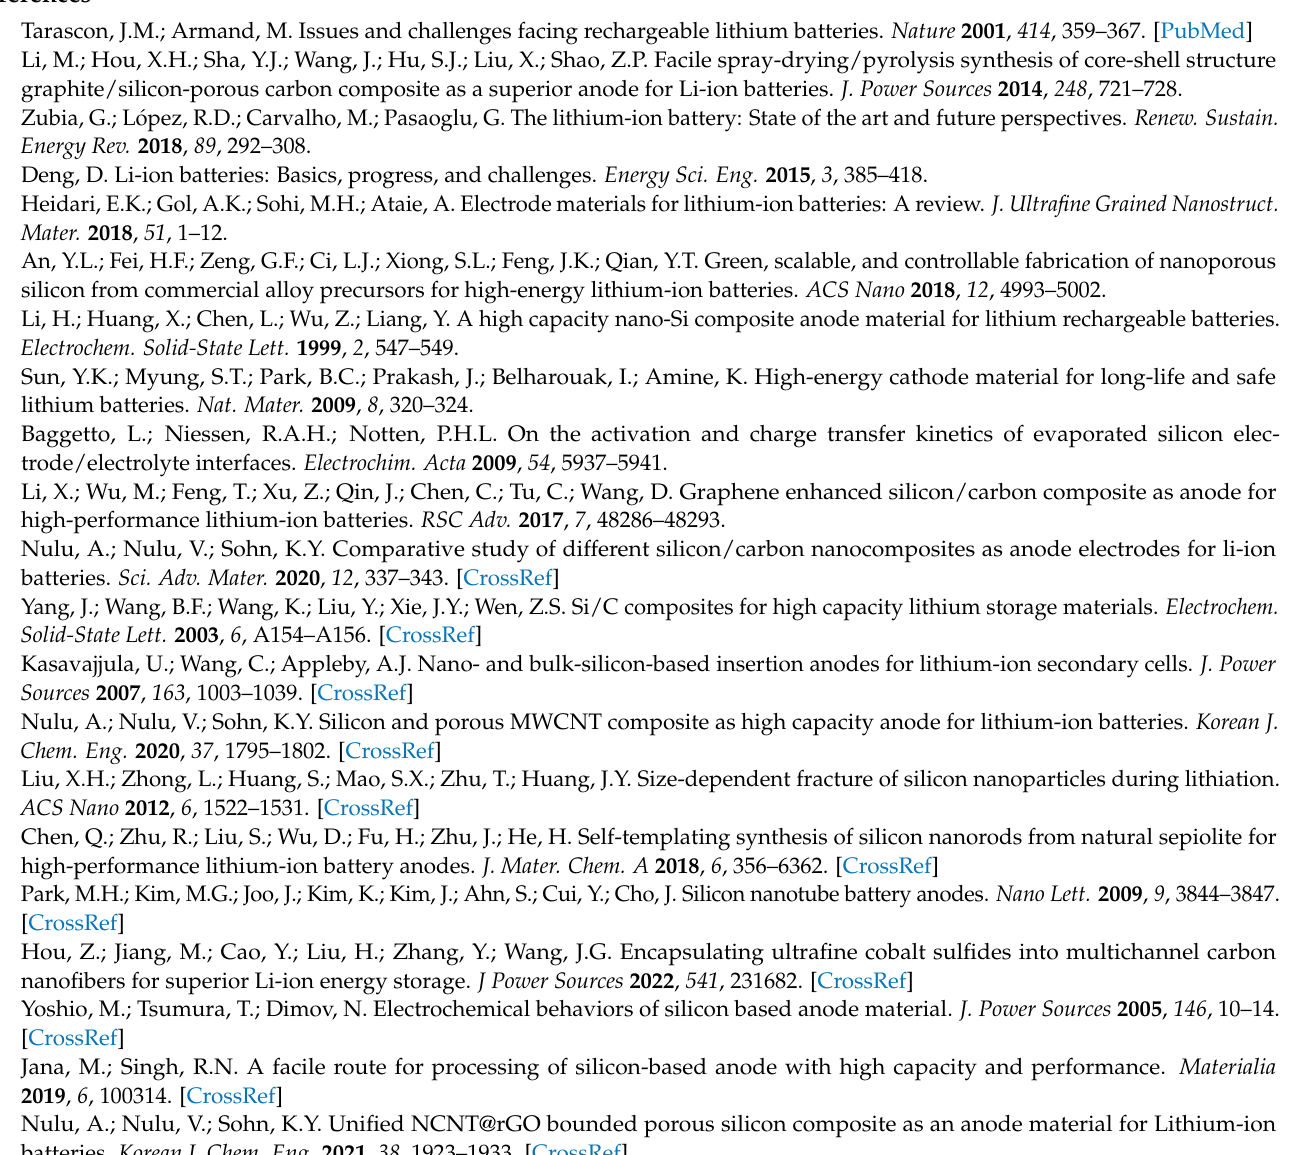
Figure S10: (a) Potential vs. specific capacity plots (b) cyclability (c) rate capability results of LCO vs. Li/L + as a counter electrode at 0.5 C, in the voltage window of 3.0–4.2